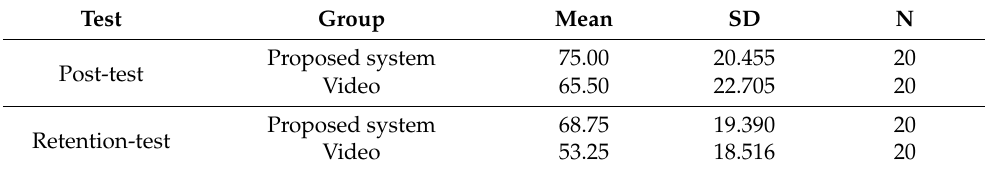
Table 2. Post-test and retention-test average results for each group.